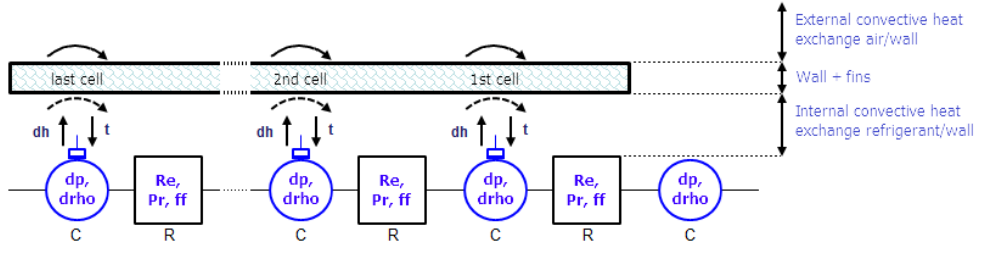
Figure 2. Diagram of discrete cell of the condenser component.